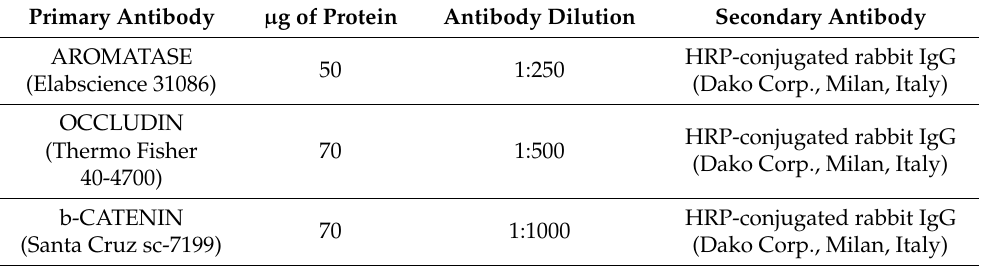
Table 2. Primary antibodies, protein amounts, antibody dilution and secondary antibodies used for western blot